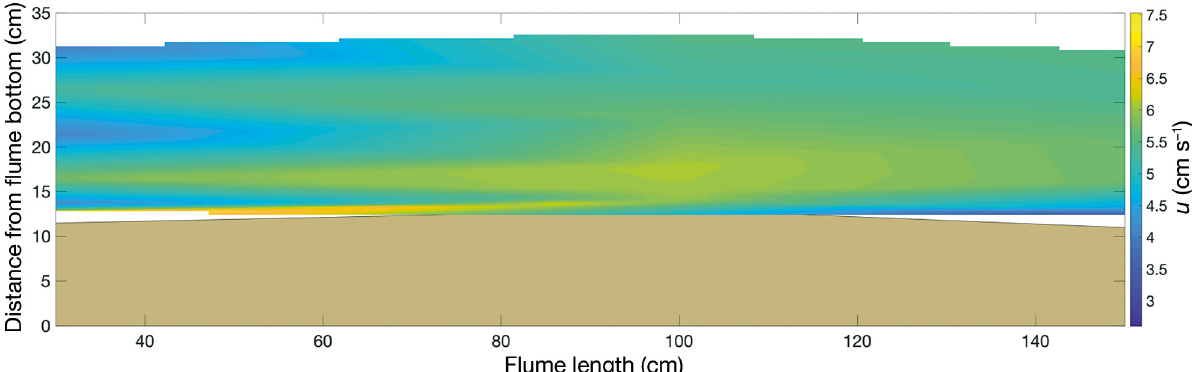
Fig. 4. Velocity profile over a sandy bottom. The influence of the propeller is evident in the first part of the flume as 2 symmetric high velocity lobes. A near homogeneous vertical distribution of velocities is attained around 80 cm from the honeycomb panel. The light brown area indicates the bottom substrate, while the white areas were not covered during the sampling